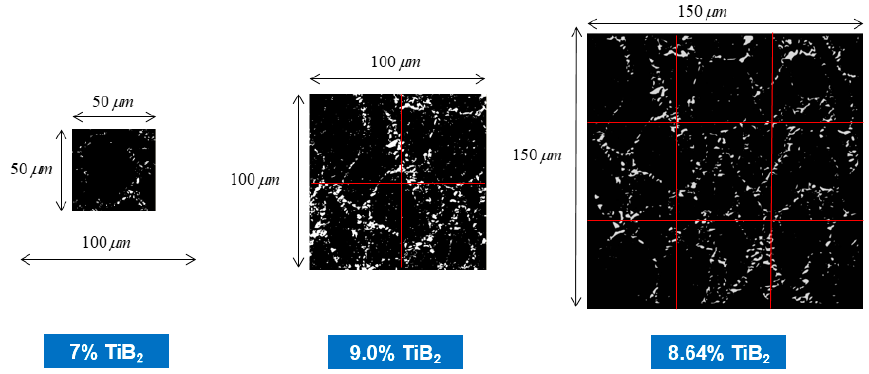
Figure A2. Example of particle area fraction obtained for increasing unit cell size for Al–TiB2 com- posite.